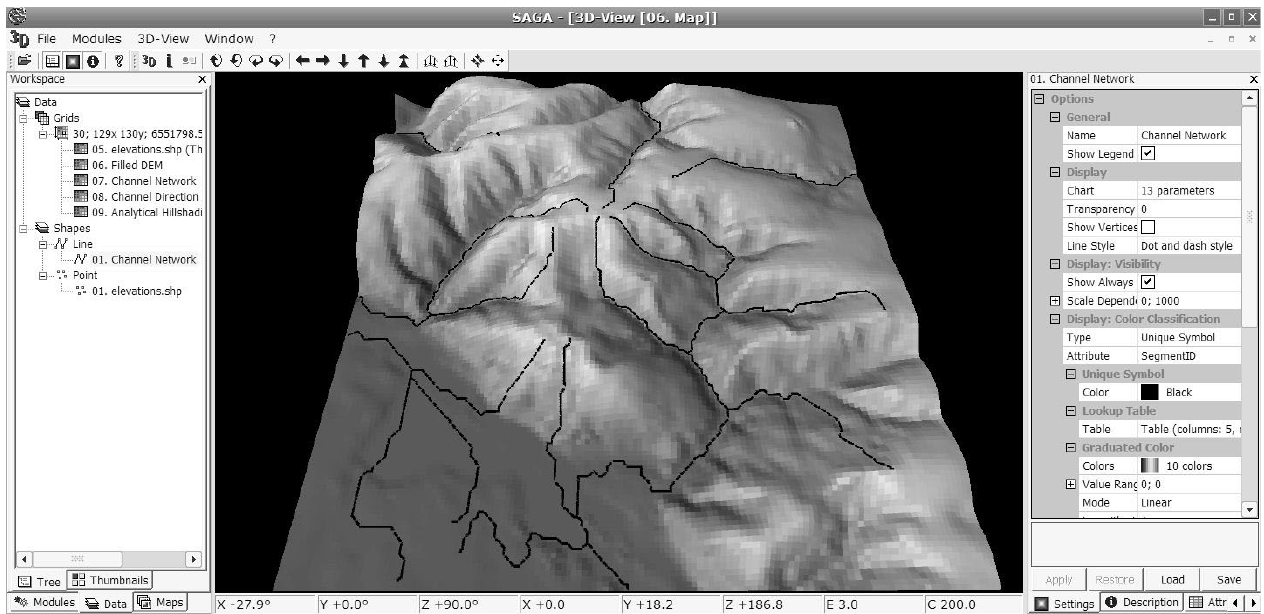
Fig. 3. Stream network generated in SAGA GIS using standard settings. In this case we used 40 (pixels) as the minimum length of streams. Case study Baranja Hill; viewed from the West